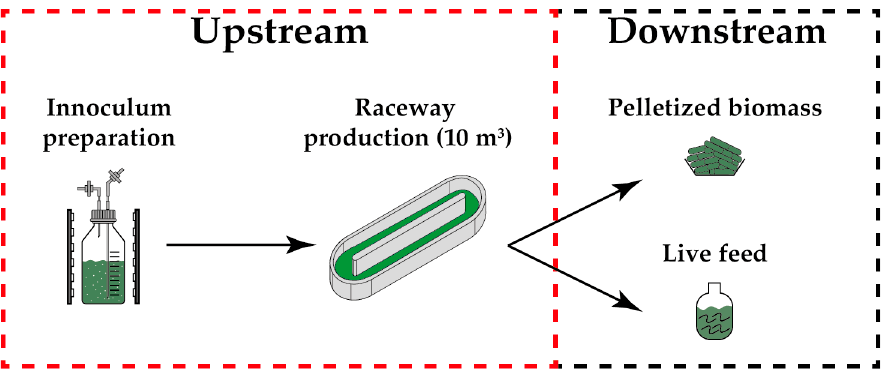
Figure 1. Process description of algal-based